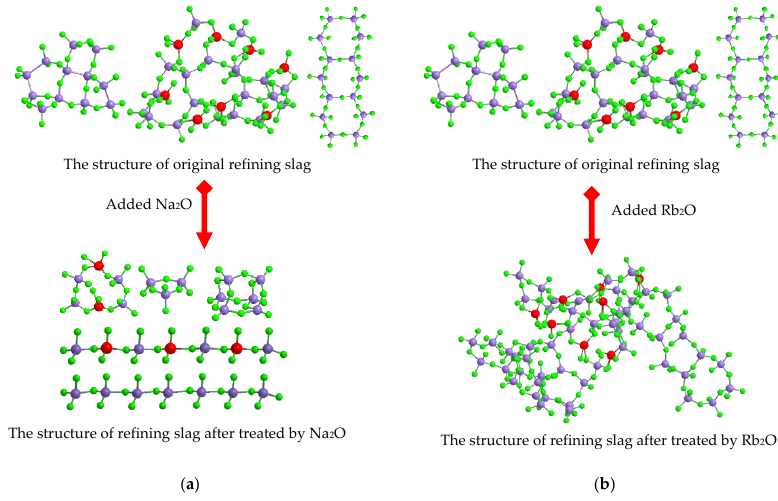
Figure 21. The structure of refining slag treated by alkali oxides ( a ) Na 2 O addition, ( b ) Rb 2 O